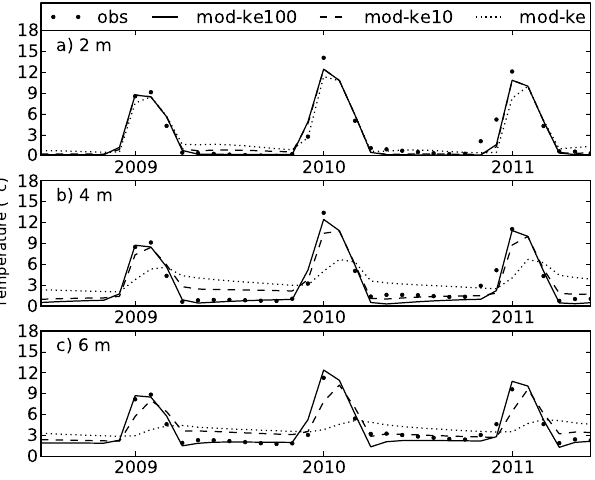
Figure 8. Comparisons of monthly average water temperatures at 1, 69 and 86cm depths below the water surface at the pond site from simulations with 20 (mod-20cm) and 2cm (mod-2cm) maximum snow thickness, over the period from 2007 to 2011.